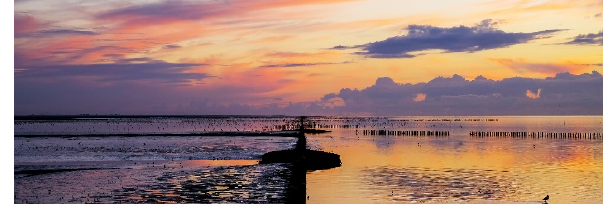
Figure 7. The Wadden sea tidal flats just after